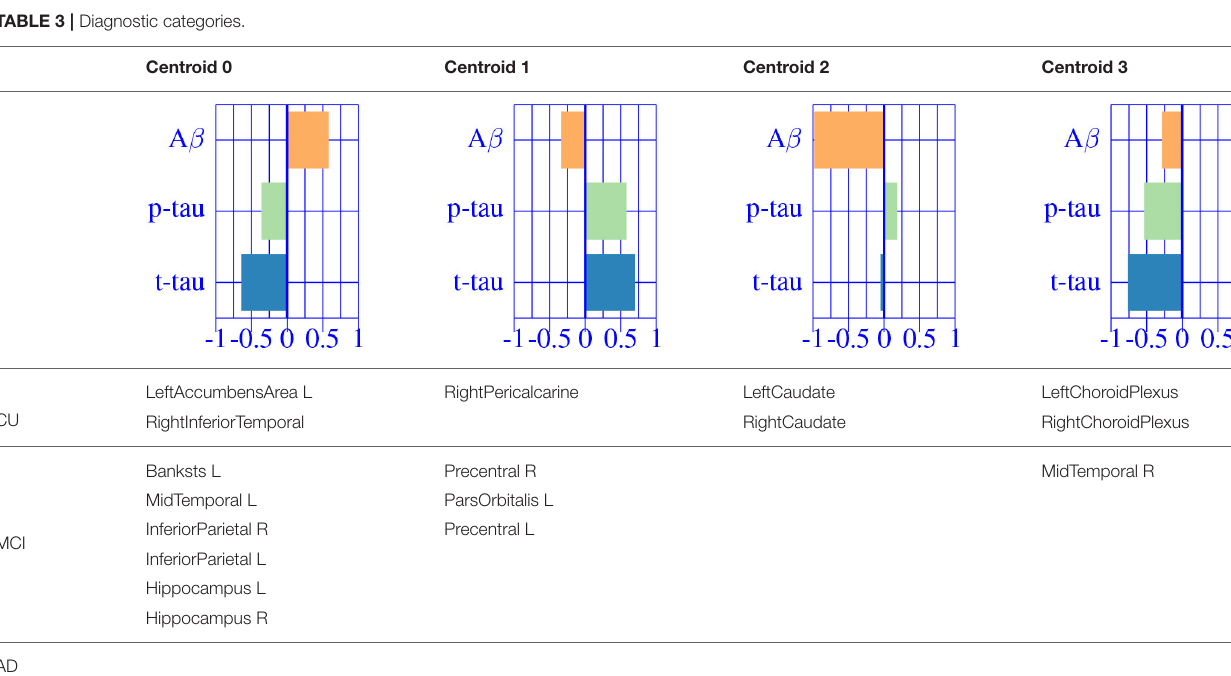
TABLE 3 | Diagnostic